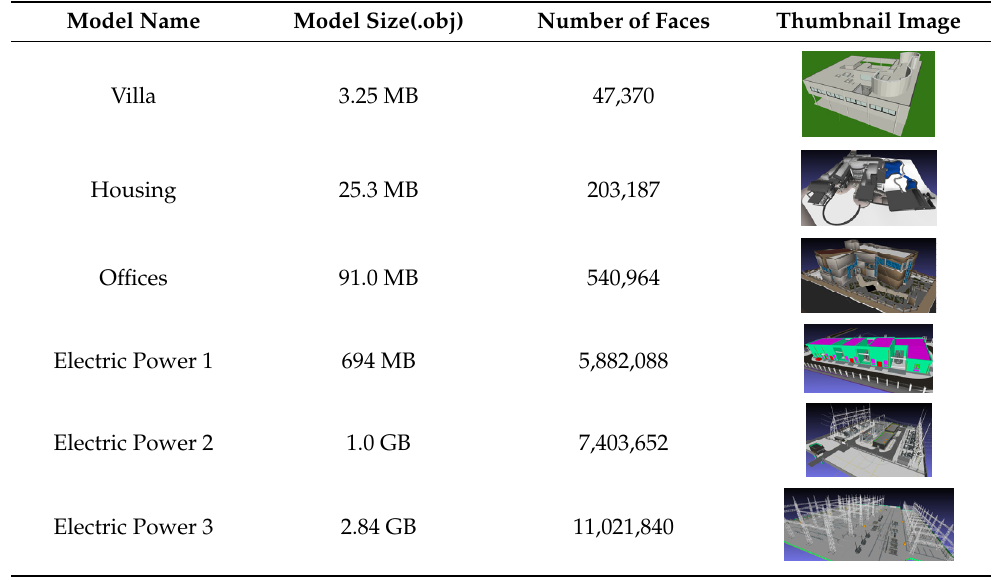
Table 1. Experimental Table 1. Experimental data. Table 1. Experimental data. Table 1. Experimental data. Table 1. Experimental data. Table 1. Experimental data. Table 1. Experimental data.